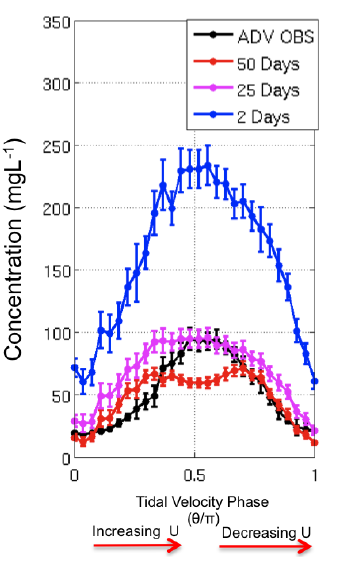
Figure 9. Phase-averaged concentration from ADV observations (black), and estimated by model using swelling times defined as 2 days (blue), 25 days (pink), and 50 days